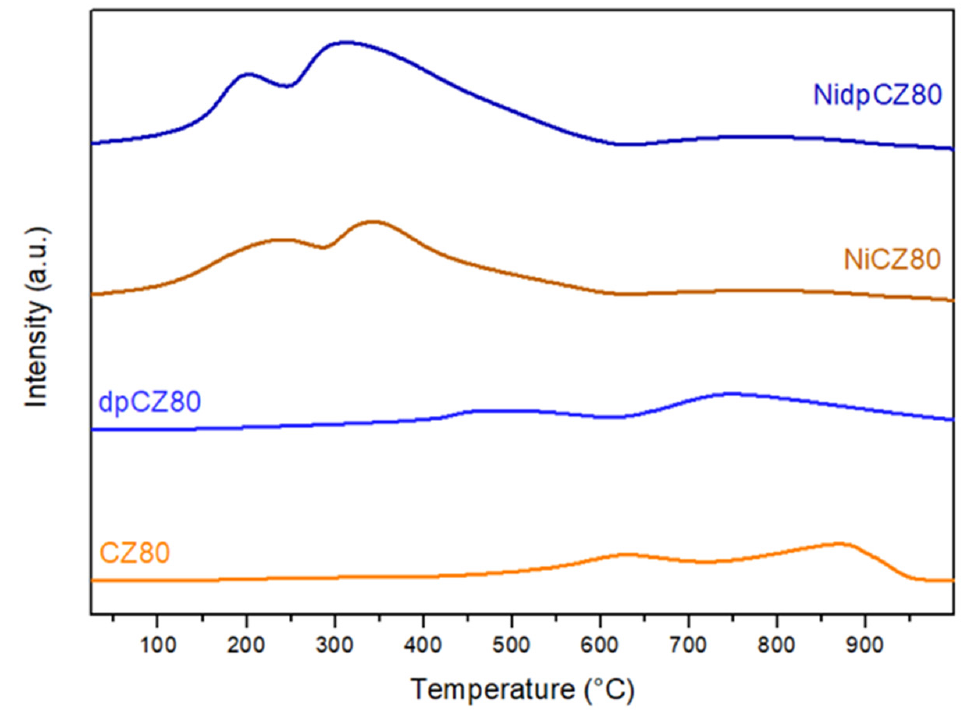
Figure 6. H 2 -TPR profiles of supports (undoped CZ80 and doped dpCZ80) and Ni supported Figure 6. H 2 ‐ TPR profiles of supports (undoped CZ80 and doped dpCZ80) and Ni supported catalysts, NiCZ80 and catalysts, NiCZ80 and NidpCZ80.TPR.